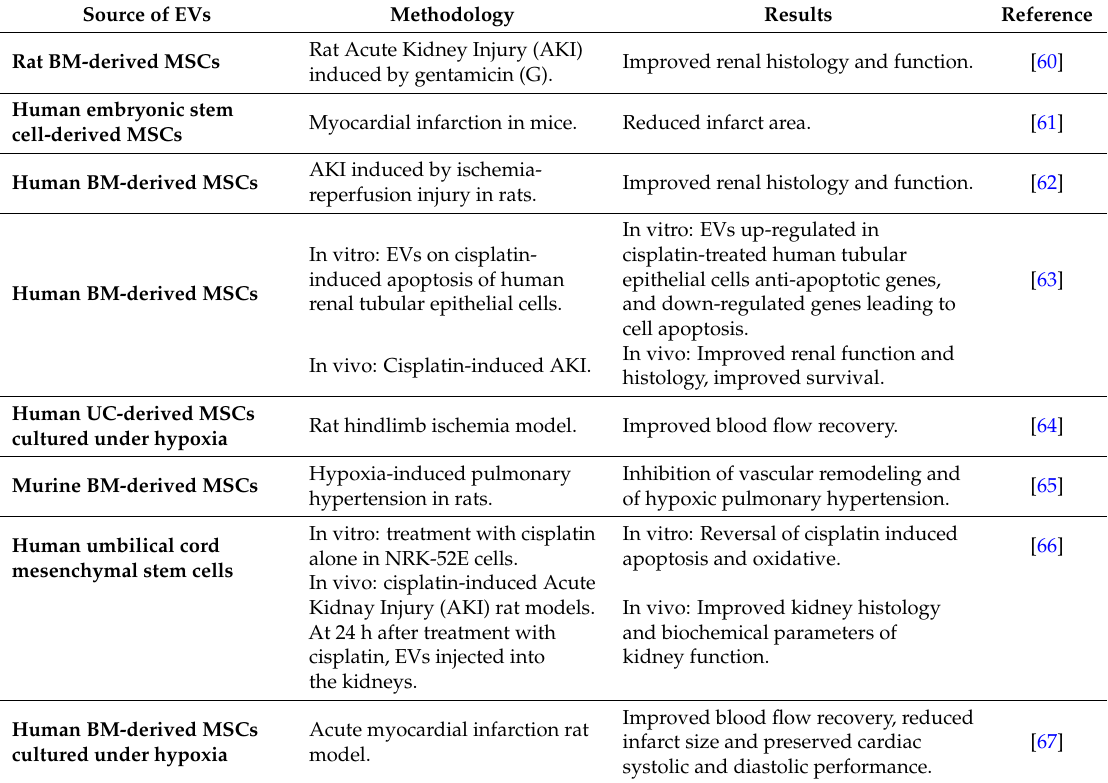
Preclinical in vivo studies on the immune modulatory and regenerative effects of MSC-extracellular vesicles